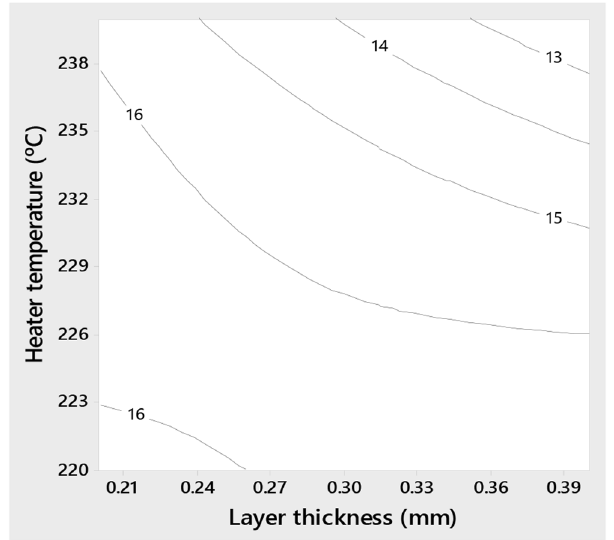
Fig. 11. Contour plot of fatigue strength versus layer thickness and heater temperature.